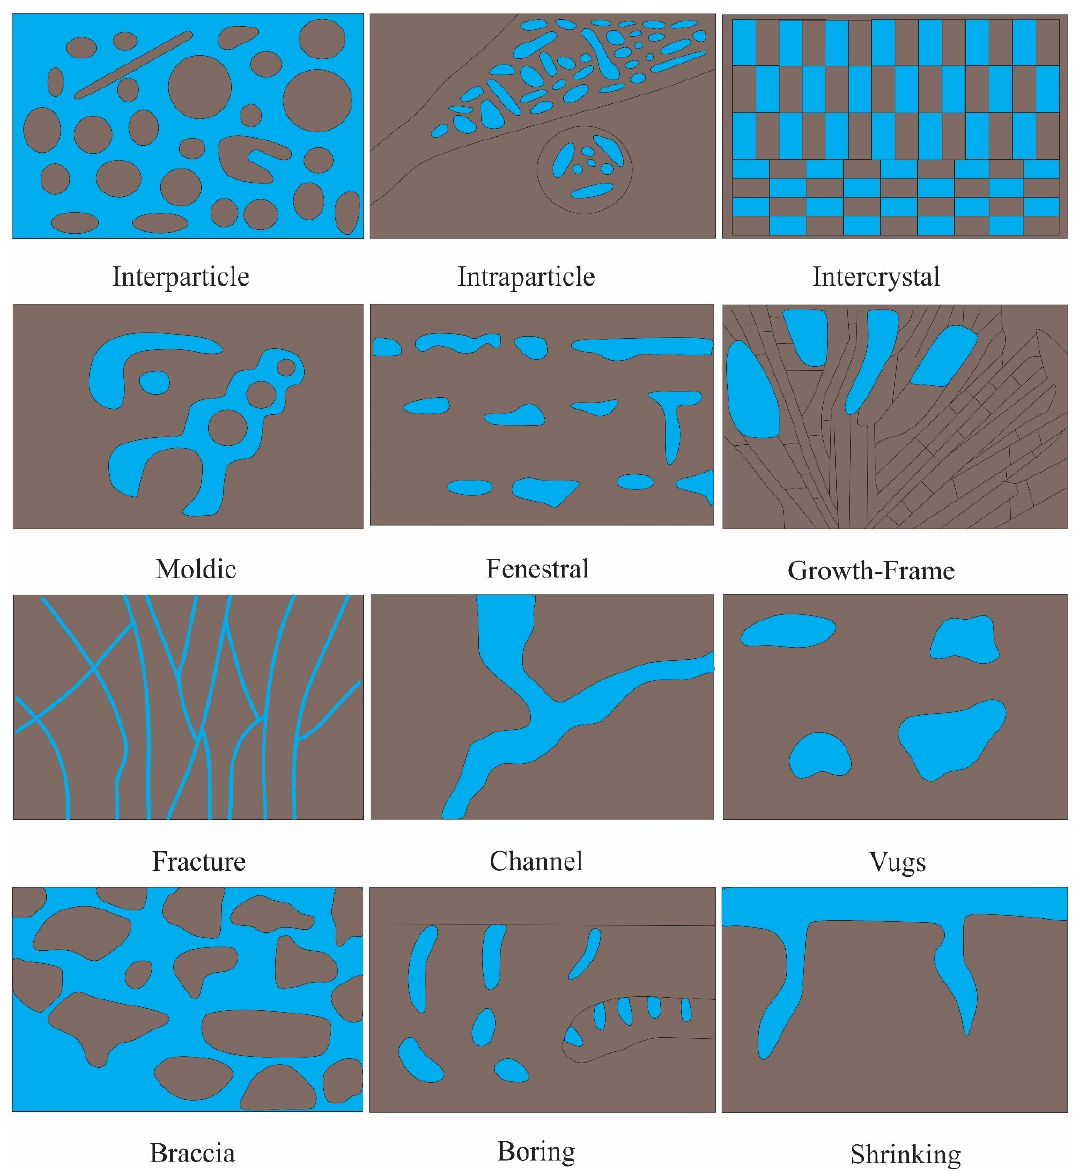
Figure 5. Choquette and Pray classification of limestone porosity. Table 3. Description of porosity classification of limestone.